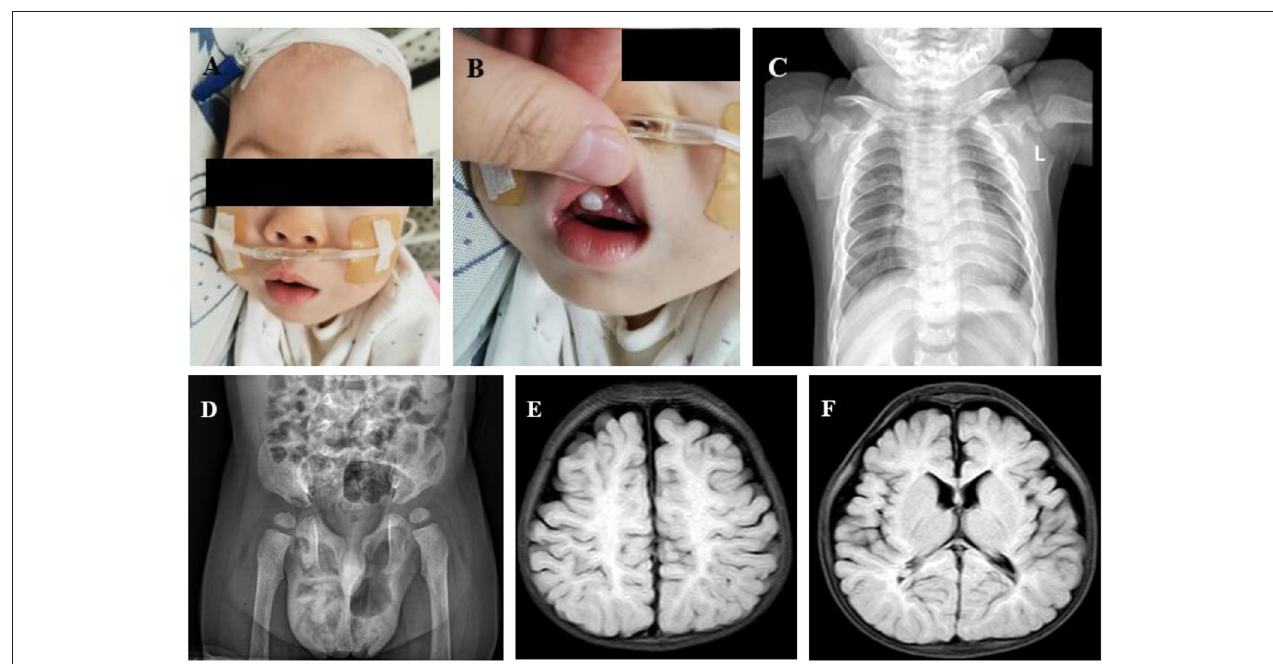
FIGURE 2 | (A) Abnormal facial features (thick arched eyebrows, a flat nose, swollen eyelids, exophthalmos, epicanthus, low-set ears, and a short neck). (B) Obvious gingival hyperplasia. (C) Anteroposterior chest X-ray: small chest shape, short floating ribs, and irregular bilateral proximal humerus. (D) Pelvis anteroposterior X-ray: sharp and deep bilateral sciatic incisions; small and shallow bilateral acetabulums. (E) Brain MRI: small bilateral frontotemporal lobes, wide extracerebral space, and less white matter. (F) Brain MRI: thinner corpus